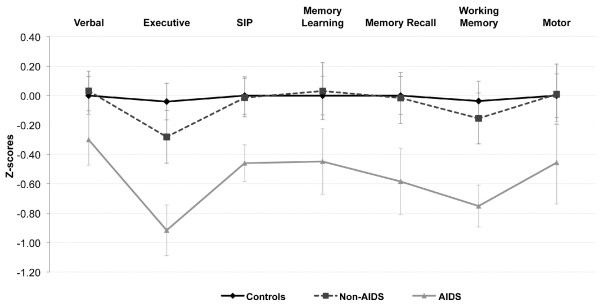
Increased cognitive impairment in AIDS patients compared to non-AIDS and HIV-controls. Mean (± standard error) ability z-scores for each group was computed for the seven ability domains, analyzed using ANOVA and post hoc Dunnett's comparison. Compared to controls and HIV+ non-AIDS individuals, z-scores of AIDS patients were significantly lower on Executive function, Speed of Information Processing, Memory Recall and Working memory (p < 0.01).